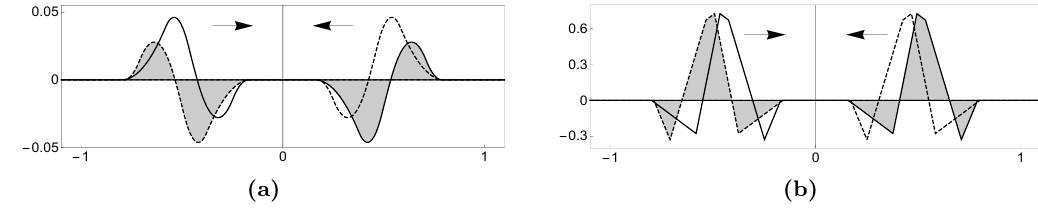
Figure 7 . Another possible symmetric initial con(cid:12)guration of two compact oscillons parametrized by V = 0 : 8, v = 0 : 3, t 0 = 0 and x 0 = (cid:0) 0 :